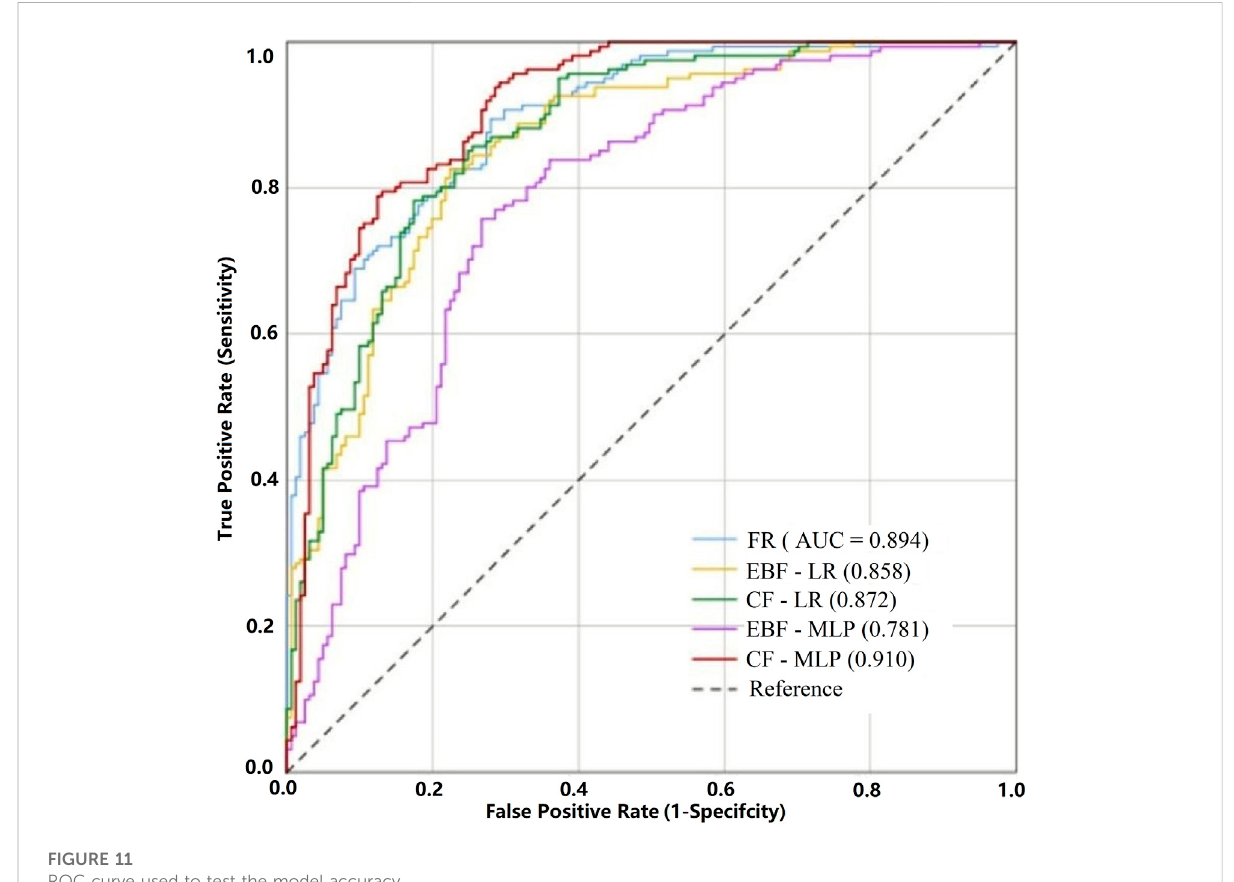
FIGURE 11 ROC curve used to test the model